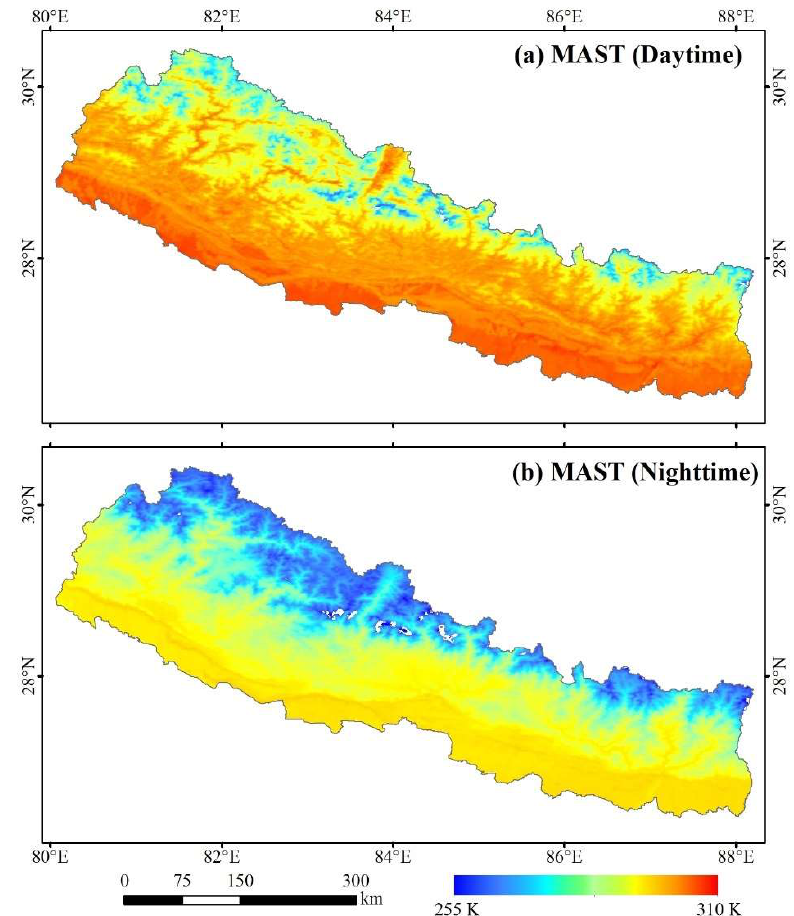
Figure 2. Annual average the mean annual surface temperature (MAST) during the period 2000 to 2017. ( a ) Daytime; ( b ) Nighttime.